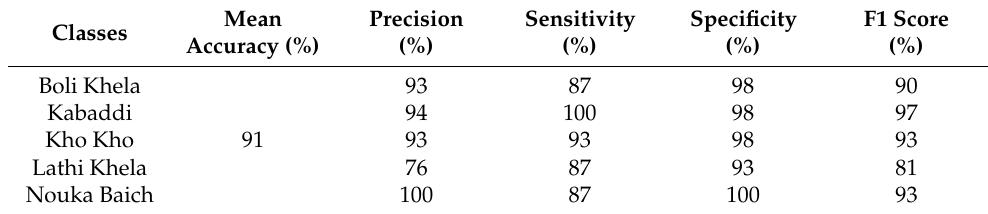
Figure 5. Examples of resized and augmented frames: ( a ) original frame, ( b ) resized frame, ( c ) horizontally flipped frame, ( d ) rotated frame, ( e ) width shifted frame, ( f ) and height shifted frame. Table 3. Class-wise performance of the scratch